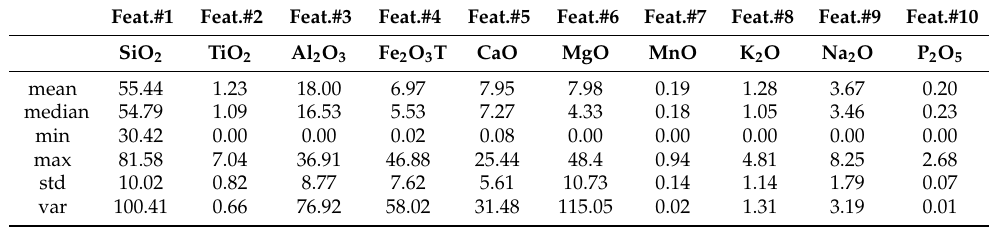
Table 7. Basic statistics of Dataset